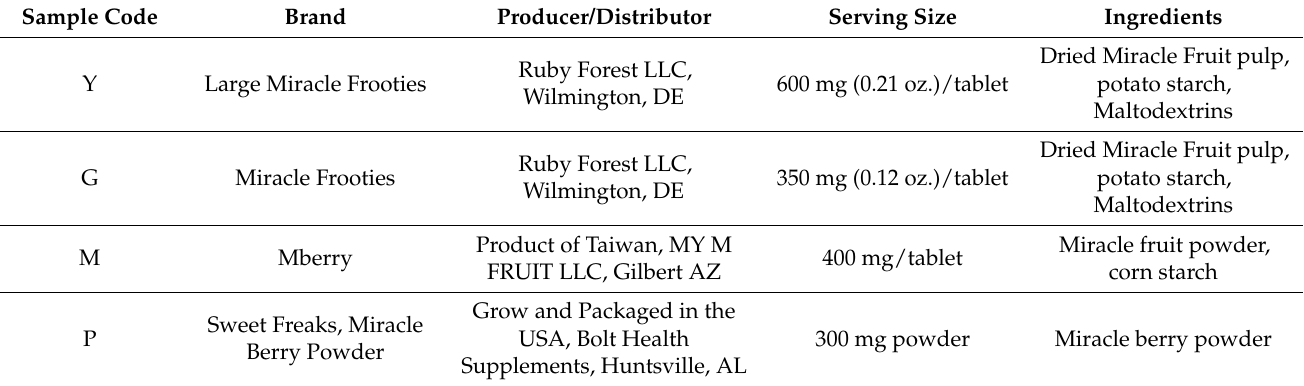
Table 1. Specifications of miracle fruit products used in this